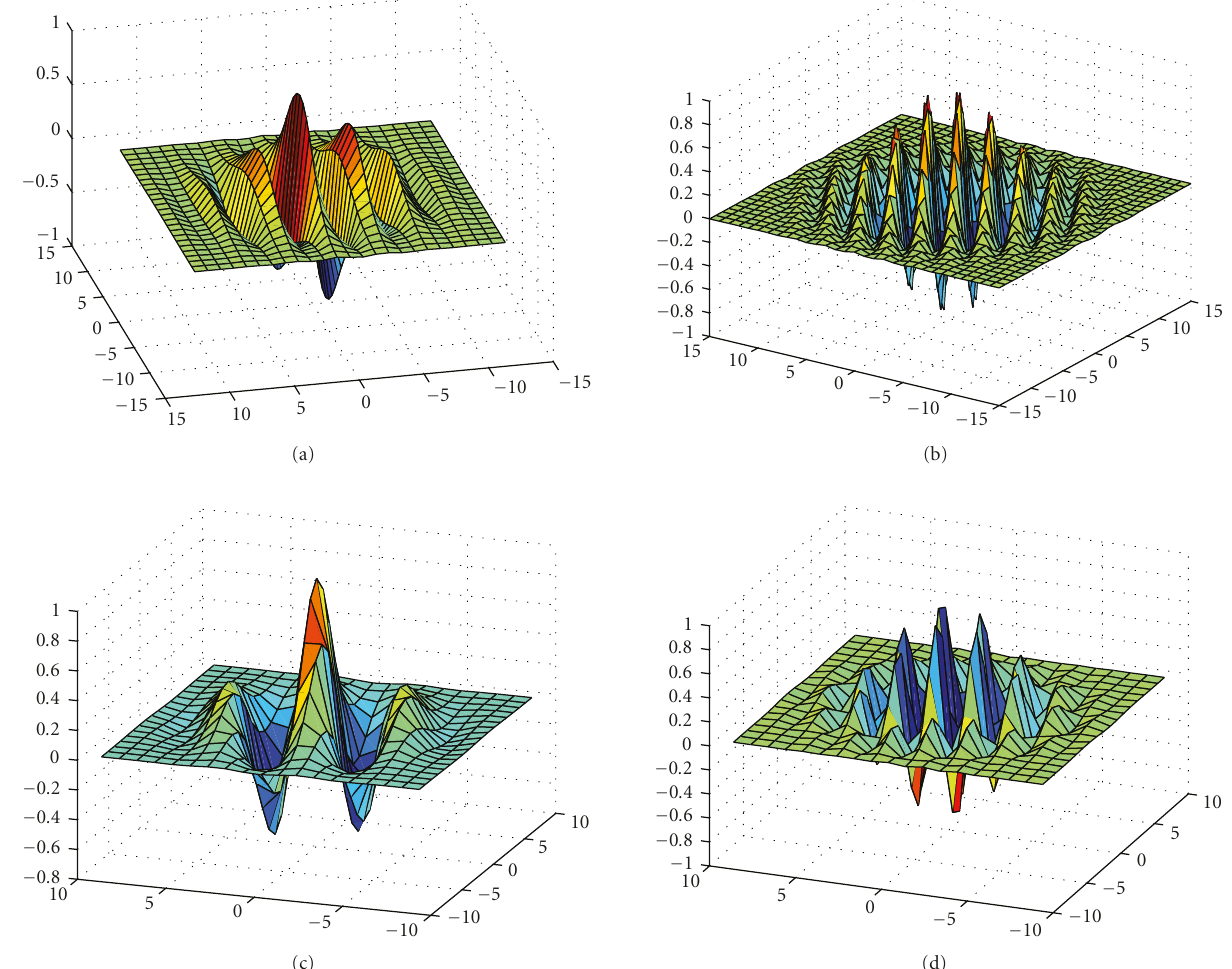
Figure 17: Examples of Gabor functions that are used in the feature extraction stage.